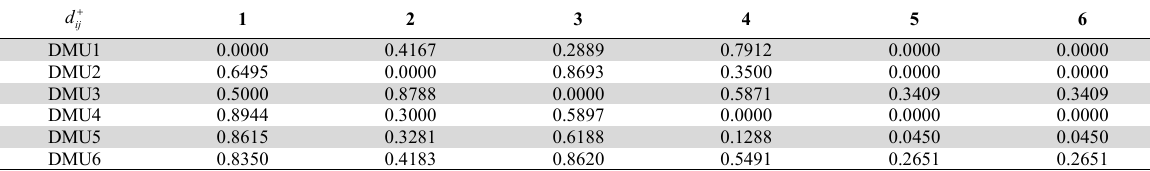
The distance from PIS for alternative i and criterion j for six nursing homes